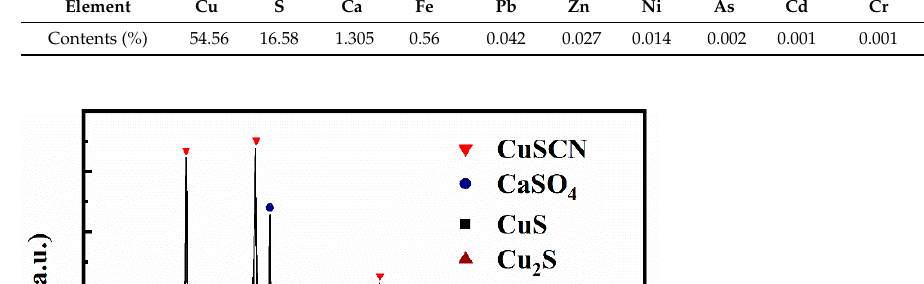
Table 3. Chemical composition of copper products.